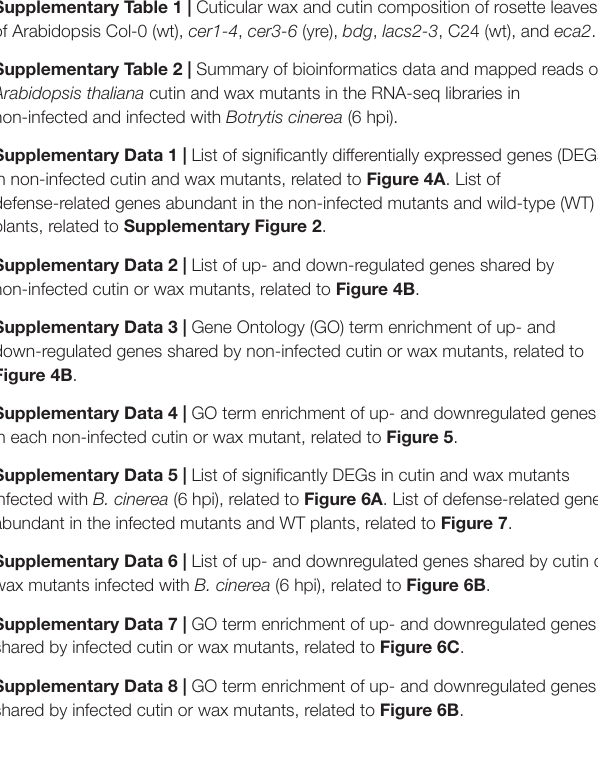
Supplementary Table 2 | Summary of bioinformatics data and mapped reads of Arabidopsis thaliana cutin and wax mutants in the RNA-seq libraries in non-infected and infected with Botrytis cinerea (6 hpi).